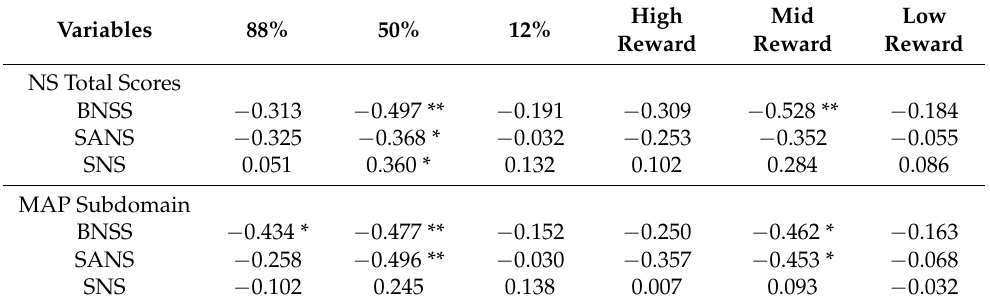
Table 3. Correlations of EEfRT performance measures with different negative symptoms scale